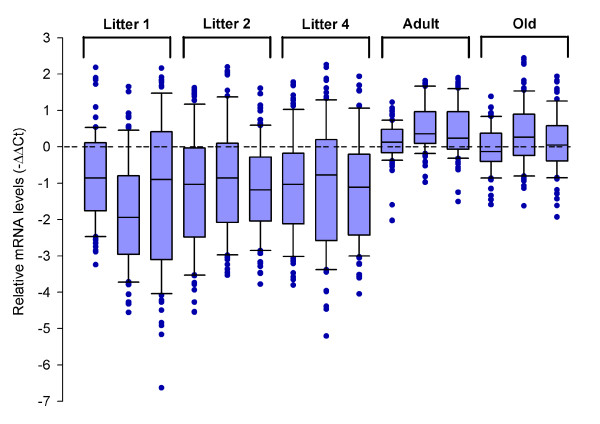
Box plots of RTqPCR data. The RTqPCR results detailed in Figure 10 are presented as box plots. Note the lower positions of the medians for the newborn samples and the greater dispersion of ΔΔCt values. A Mann-Whitney test performed with the 77 values calculated for the different samples confirmed that the data obtained for newborns differed from those obtained for the old and adult groups (p values < 10-10).